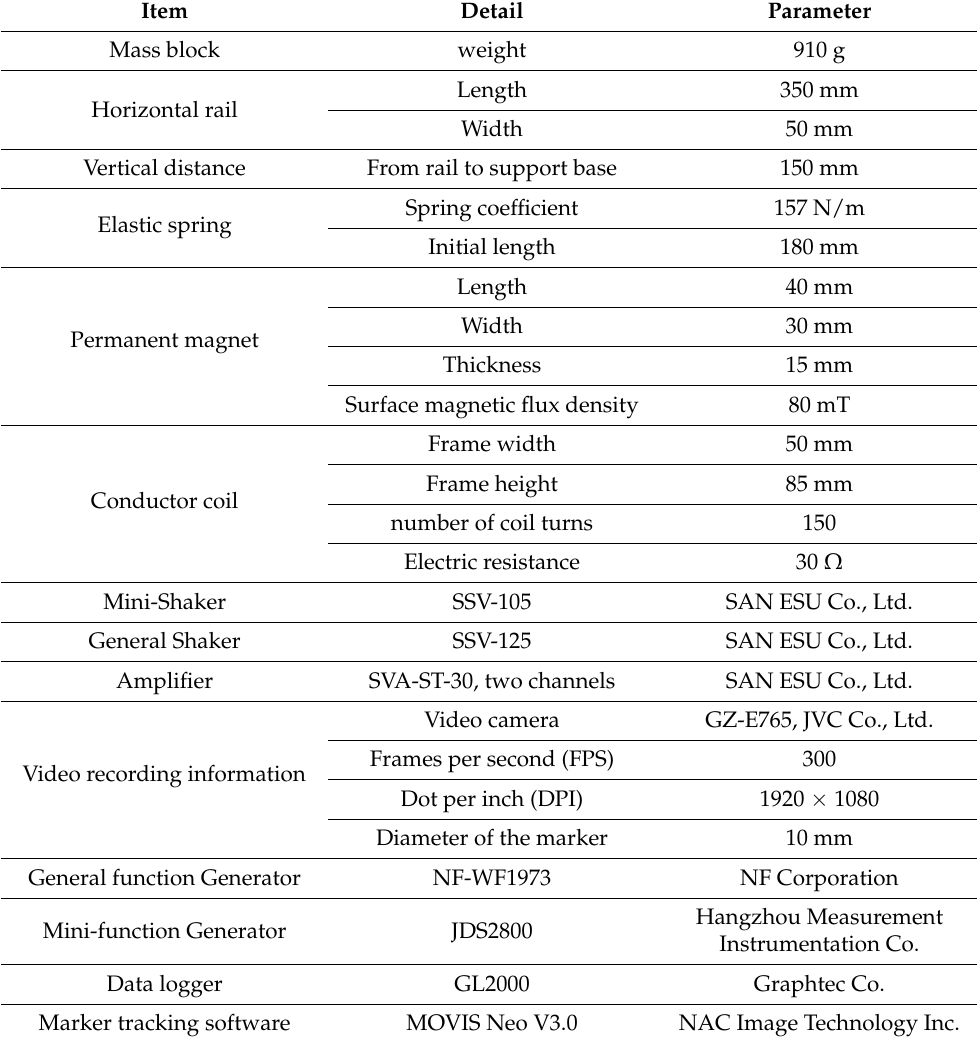
Table 1. Settings of experimental